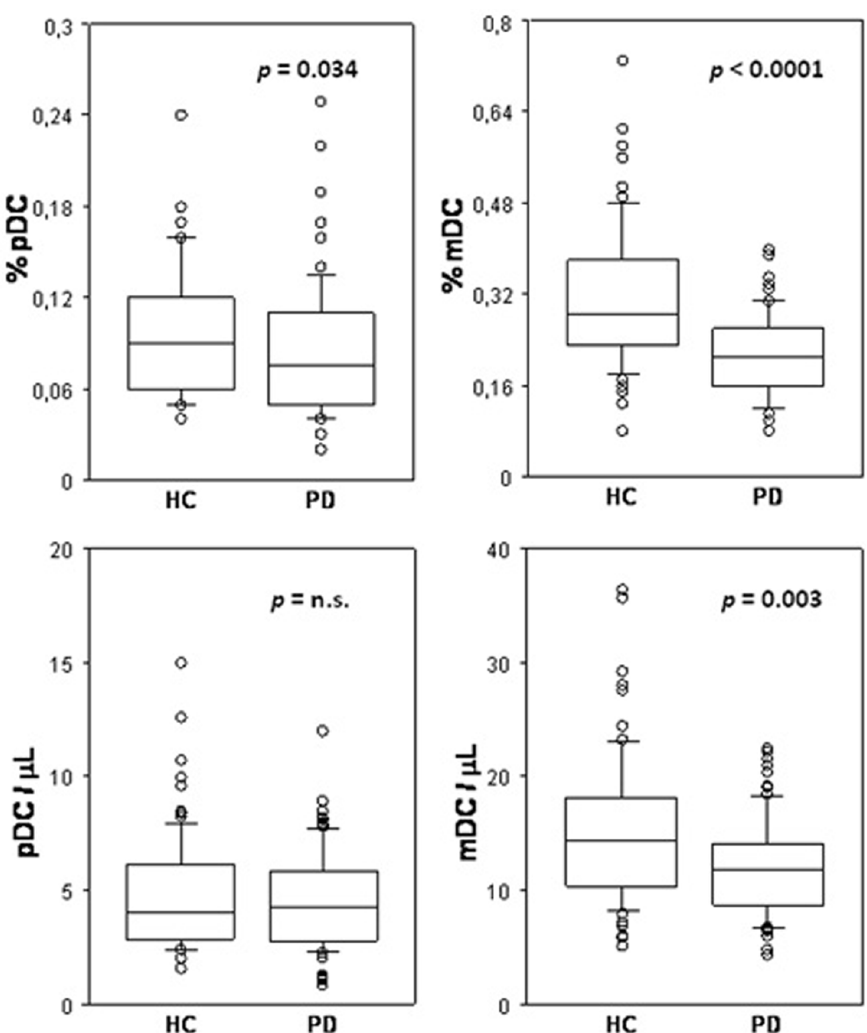
Figure 2. Blood DC decline in PD. The distribution of percentage values (upper panels) and total counts (lower panels) of pDC (left panels) and mDC (right panels) present in blood of HC (n=80) and PD (n=80) subjects is reported in the respective box-and-whisker plot, as indicated.